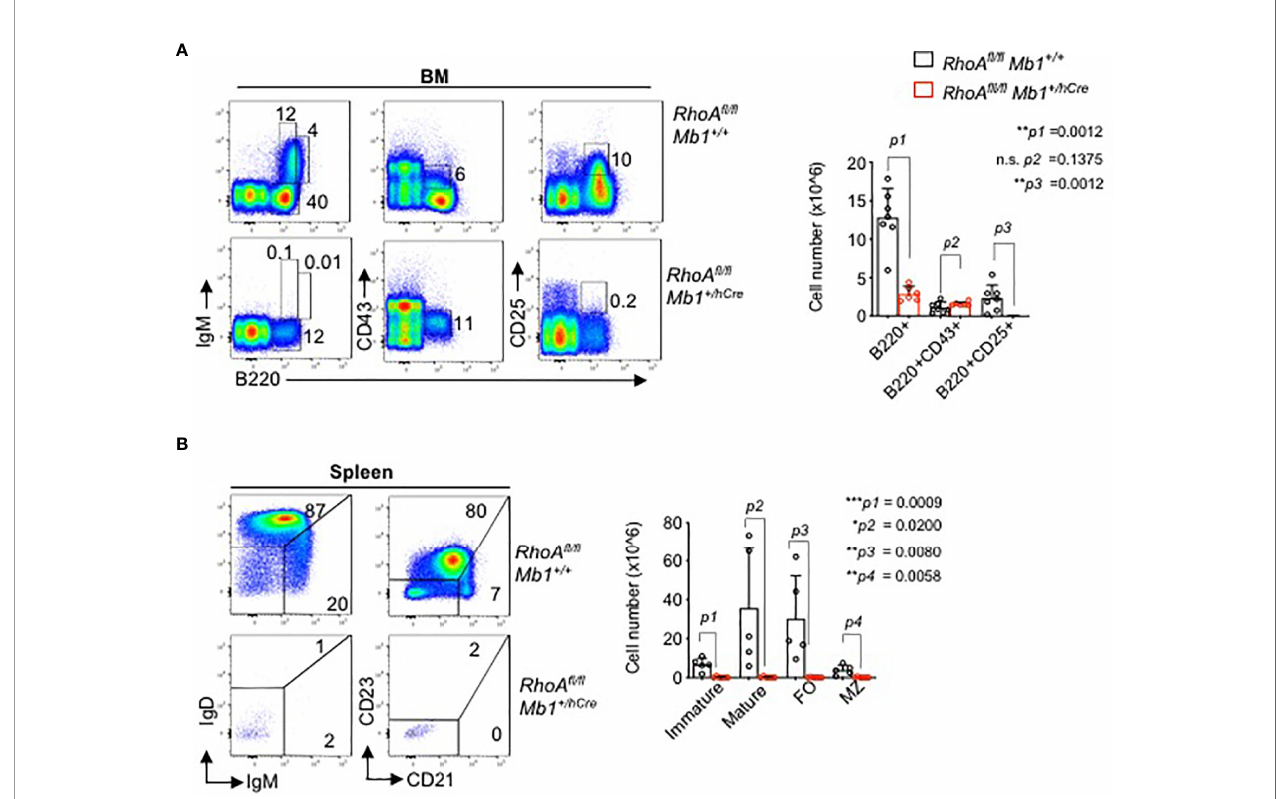
FIGURE 4 | B cell speci fi c RhoA deletion leads to developmental block at the pro B cell stage. (A) Flow cytometric analysis of freshly isolated cells from bone marrow (BM) of RhoA fl / fl and RhoA fl / fl Mb1 +/hCre mice for surface expression of the indicated markers. Data are representative of 6 mice. Right: absolute cell numbers of B220 + , pro-B cells (B220 + CD43 + ), and pre-B cells (B220 + CD43 - ) in the BM. (B) Flow cytometric analysis of cells isolated from spleen of RhoA fl / fl and RhoA fl / fl Mb1 +/hCre mice. Right: absolute cell numbers of splenic B cells, immature (IgM hi IgD.), mature (IgM low IgD + ) MZ: marginal zone (CD21 hi CD23 - ), FO: follicular (CD21 low CD23 + ). N=5 mice, statistical signi fi cance was calculated using two-tailed unpaired t-test. *p<0.05, **p<0.01, ***p< 0,001, ns, not signi fi